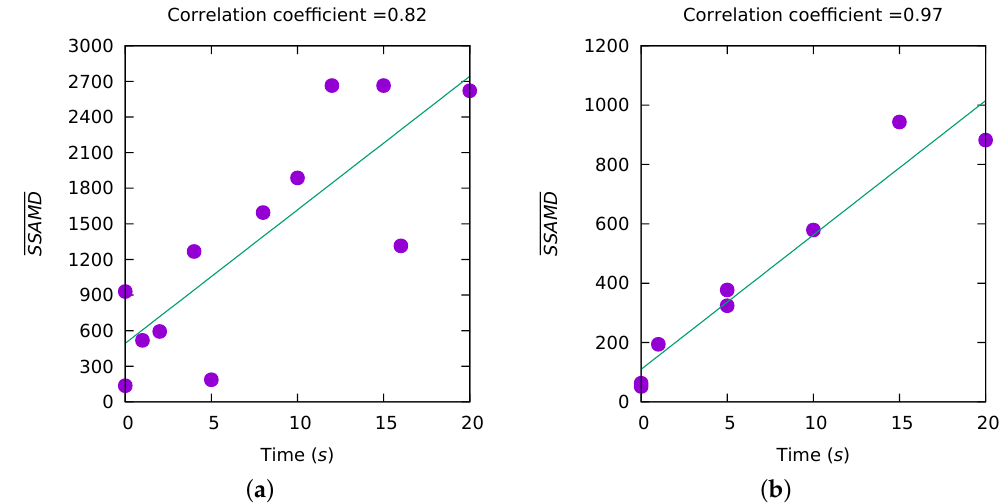
Figure 8. Biomass estimation. ( a )—Experiment IIIa; ( b )—Experiment